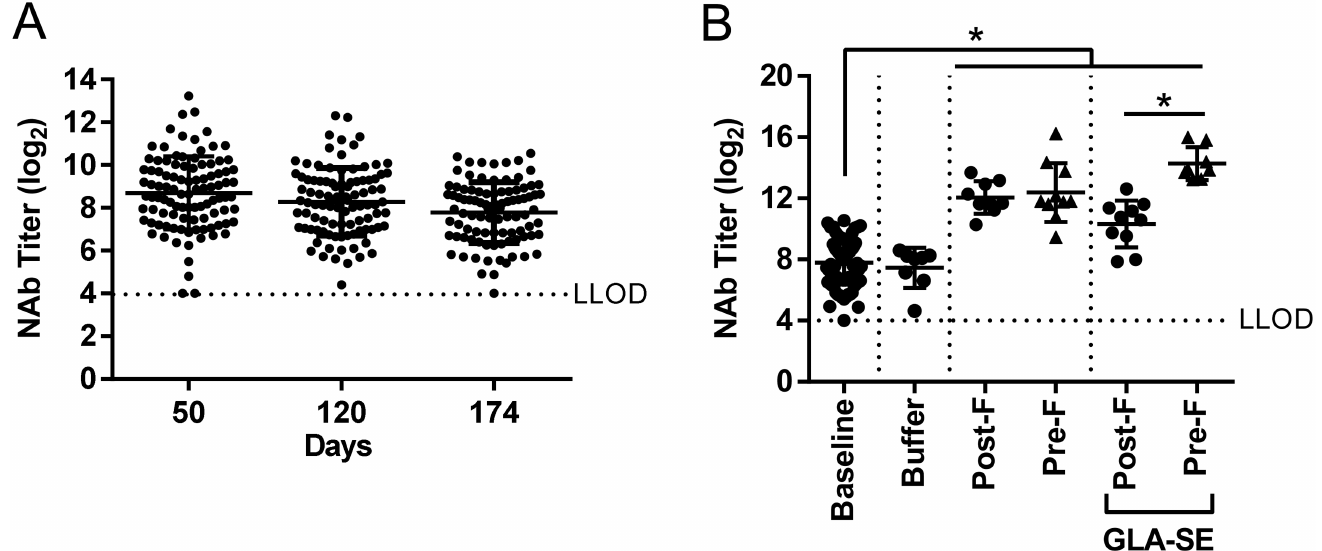
Fig 7. NAb induction of pre-F and post-F formulations in aged seropositive mice. 12 months old mice were i.n. immunizedwith RSV A2 (10 6 PFU) at day 0 and RSV B (10 5 PFU) at day 60. Aged seropositivemice were then immunized i.m. at day 176 (18 months old) with buffer alone, post-F or pre-F (0.3 μ g) +/- GLA-SE (2.5 μ g/2%) adjuvant. (A) Bleedswere collectedat day 50, 120, and 174 to assess the levels of RSV A2 neutralizing antibodiesin seropositive animalsprior to immunization(baseline). Data is presentedas the log 2 dilutionof serum that provides 50% reduction in viral entry with a LLOD of 4 indicatedby a dashed line. (B) 14 days post immunization, RSV A2 neutralizationtiters were evaluated. Group means ± SD of individualmice are shown. For statistical analyses, multiplicityadjustedANOVA test was performed againstbaselineas a control group, followedby pairwisetesting of post-F versus pre-F, * for P <